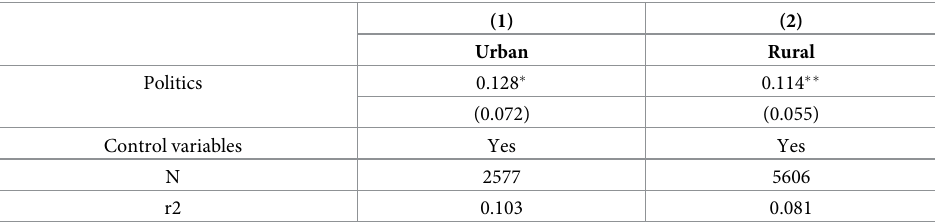
Table 7. Comparison between urban and rural